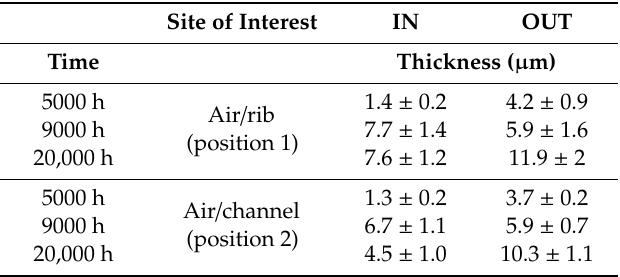
Table 3. Thickness variation of the TGO according to the exposition time, site of interest and sampling site. Average values with standard deviations in thickness on at least 5